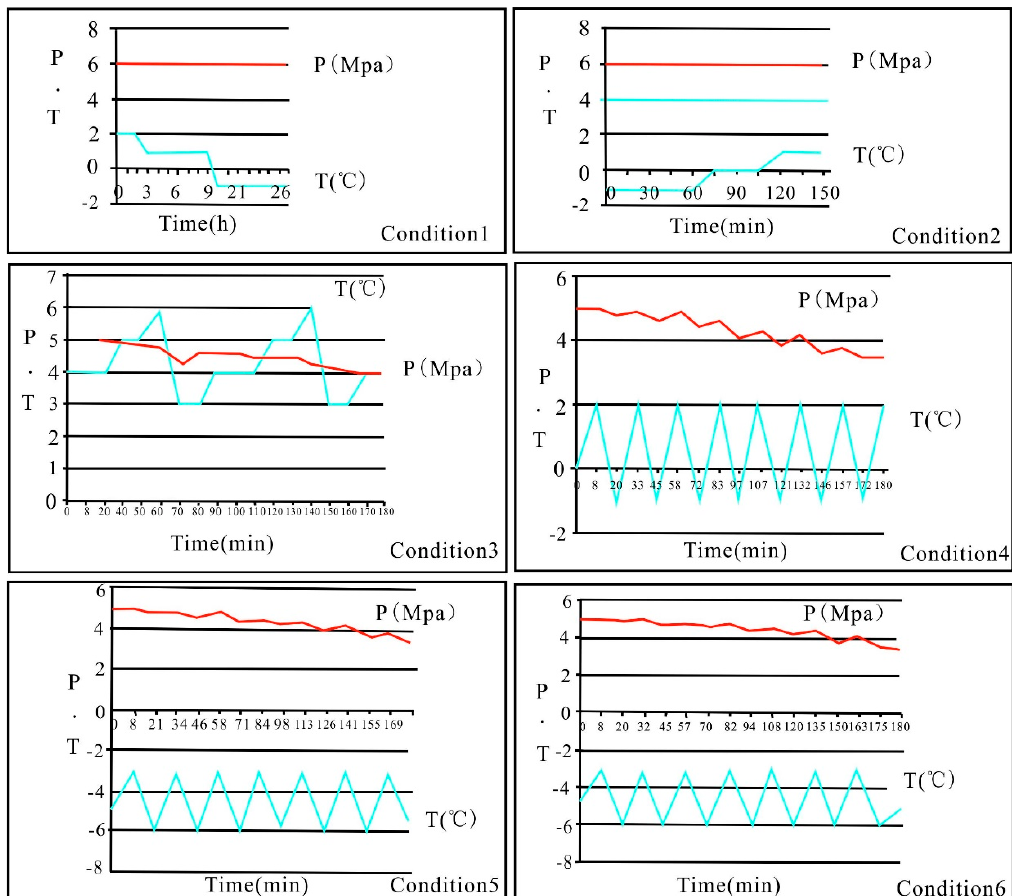
Figure 5. Curves of temperature and pressure change with time in the reactor.